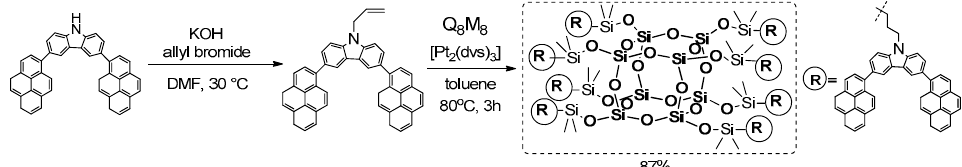
Figure 30. Functionalization of octahydrospherosilicate with N -allyl-carbazole derivative.